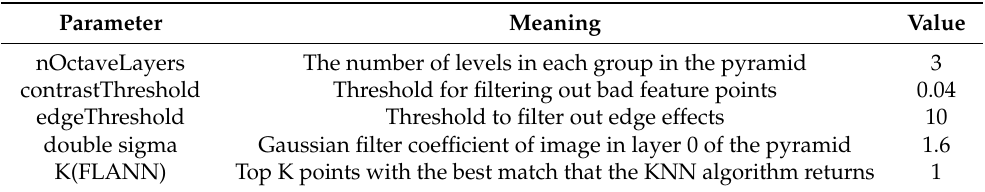
Table 2. Parameters of SIFT